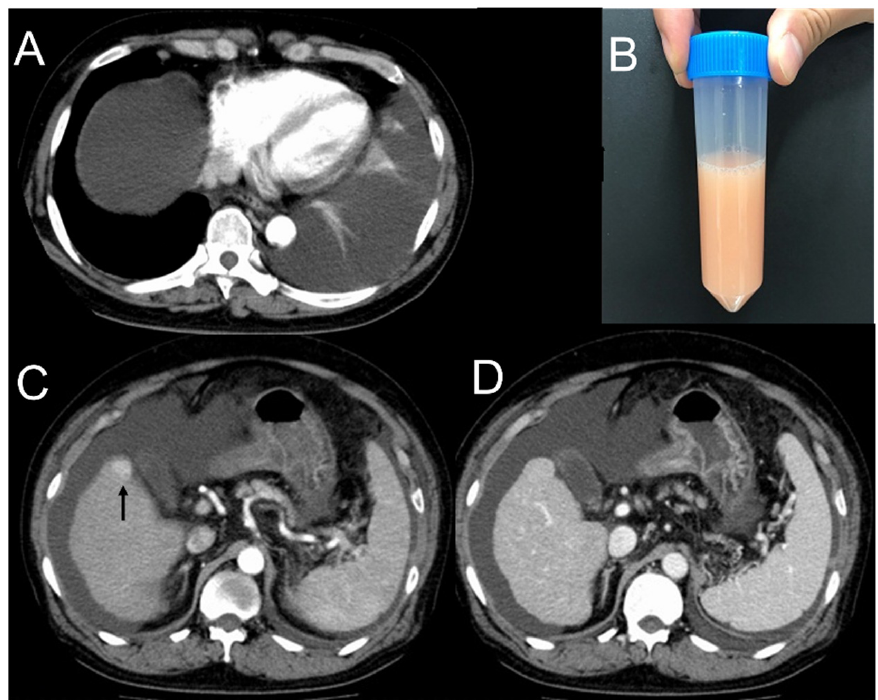
Figure 1. Imaging of chylothorax and computed tomography. ( A ) Computed tomography showed left pleural effusion and ascites. ( B ) The color of pleural effusion obtained by thoracentesis was milky white. ( C , D ) Contrast-enhanced computed tomography showed a 2-cm mass in the liver S6 that was enhanced in the arterial phase and washed out in the portal phase.